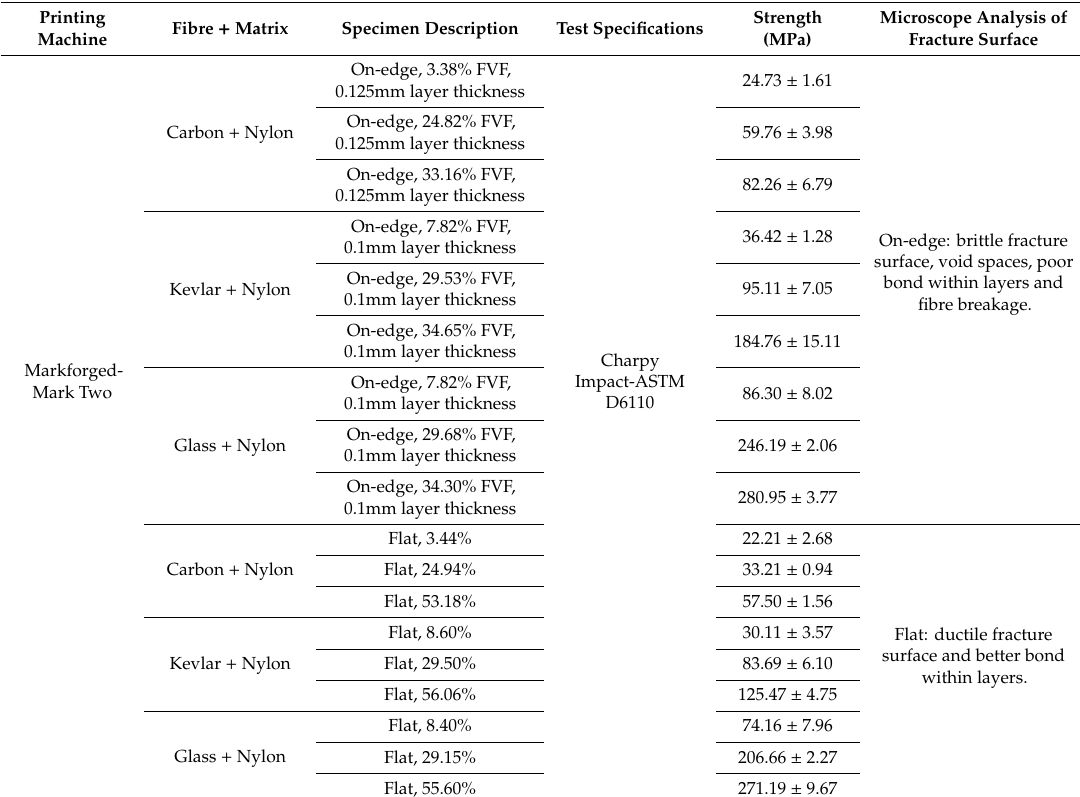
Table 1. Printing specifications, fibre volume fraction (FVF), impact strength and microscopic analysis details